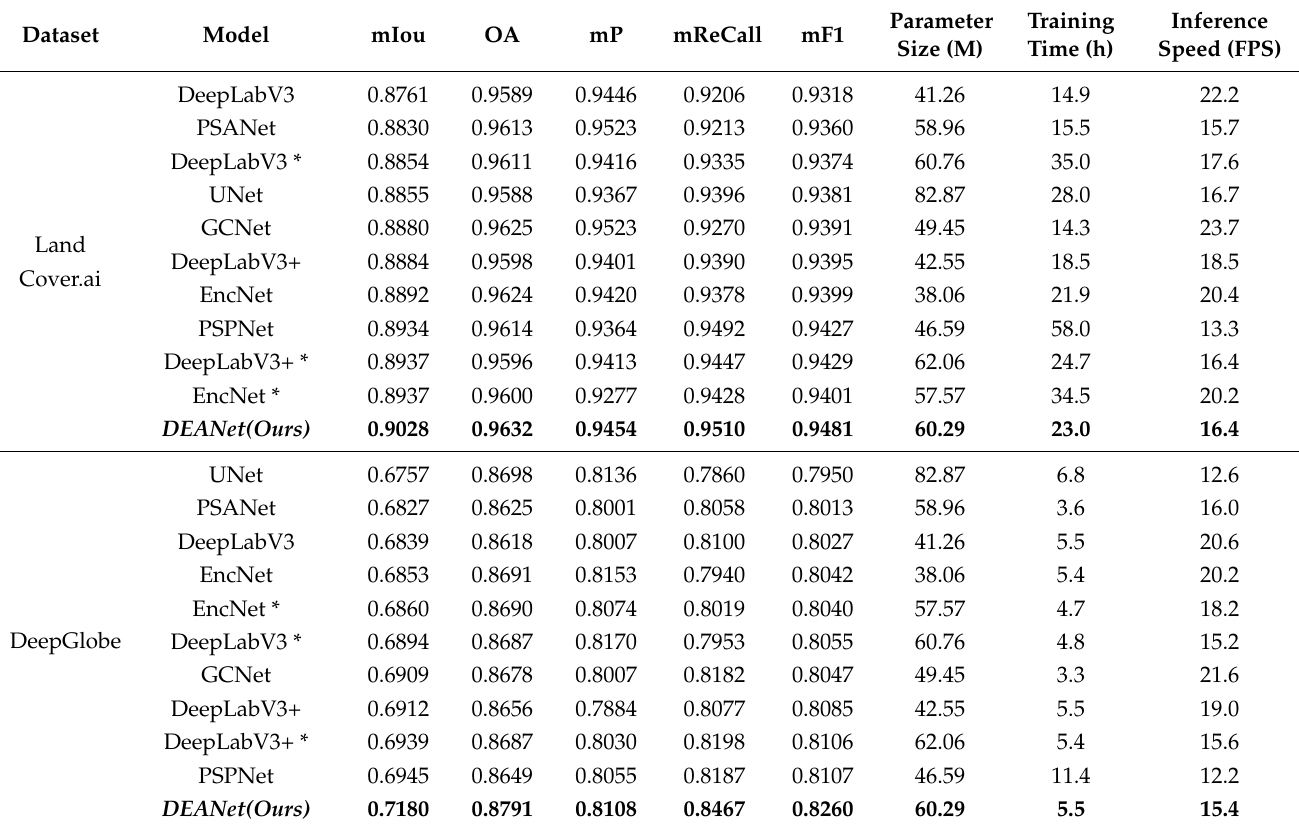
The quantitative results of the experiments on all datasets are shown in Table 9, and the size of model parameters, training time and inference speed are also inculded. And the visible results of three datasets are shown in Figures 6–8 separately, where each row represents the prediction result of a sample in the testing set. Table 9. The quantitative results of the state-of-the-art models on the three datasets. (* represents using a 101-layer resnet.).